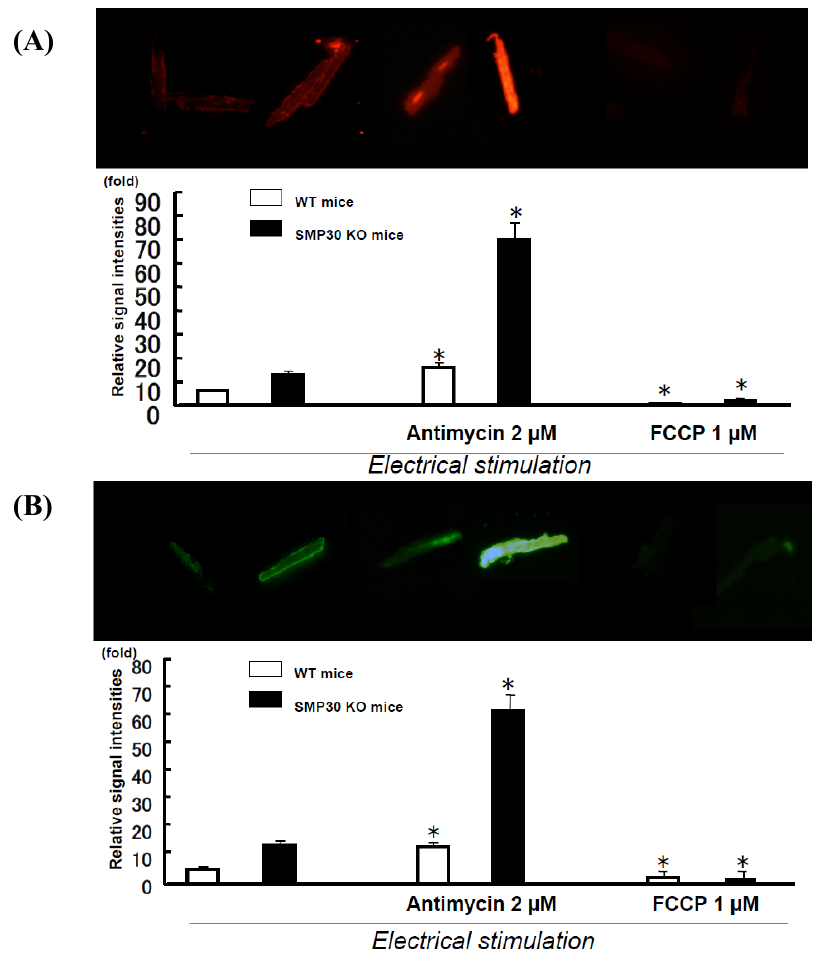
Figure 3. DHE and DCF staining in paced cardiac myocytes with antimycin or FCCP. Representative DHE ( A ) and DCF staining ( B ) in cardiac myocytes (Upper panel). Summary data of DHE and DCF staining in cardiac myocytes (Lower panel). The signals of DHE and DCF were enhanced by antimycin (2 μ M) and attenuated by FCCP (1 μ M). Values are expressed as the mean ± S.E.M. * p < 0.01 vs. without agents ( n = 12 each).